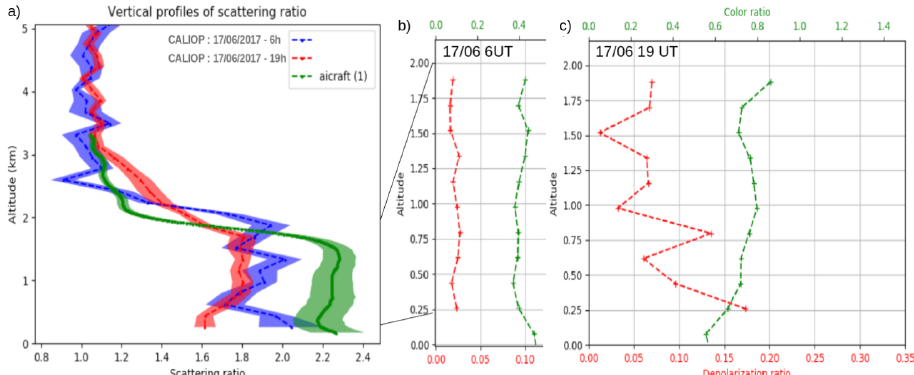
Figure 17. ( a ) Vertical profiles of 532 nm backscatter ratio for the aircraft lidar in red box of Figure 14a (red line) and for CALIOP on 7 June 2017 at, respectively 6 UT (56.7 ◦ N,83.7 ◦ E) and 19 UT (57.3 ◦ N, 87 ◦ E). ( b ) Vertical profiles of the particle color ratio (green) and particle linear depolarization ratio (red) measured by CALIOP on 7 June 2017 at 6 UT. ( c ) Vertical profiles of the particle color ratio (green) and particle linear depolarization ratio (red) measured by CALIOP on 7 June 2017 at 19